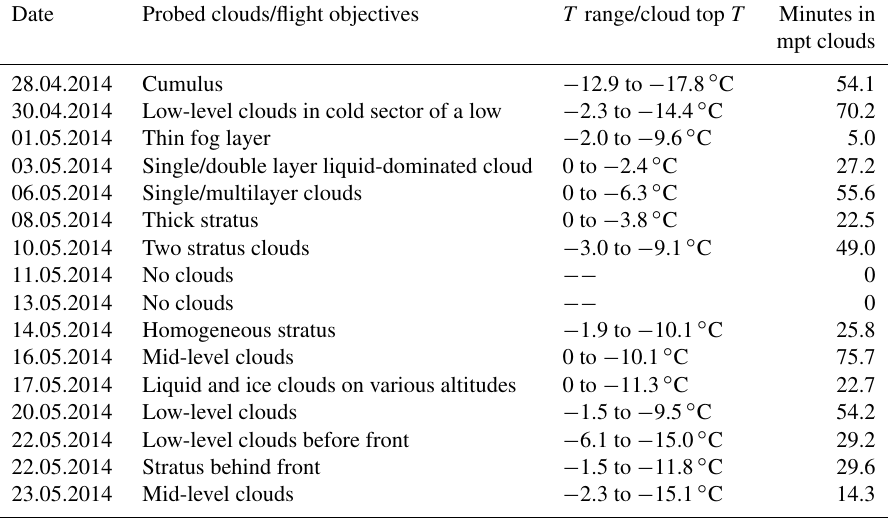
Table 4. Flight table for RACEPAC. Dates are dd/mm/yyyy.